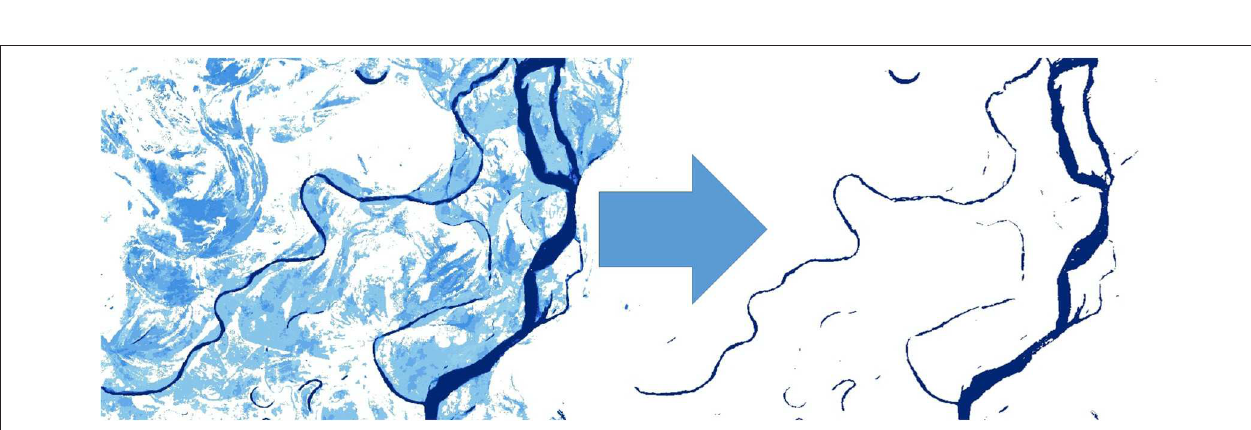
Frontiers in Environmental Science | www.frontiersin.org